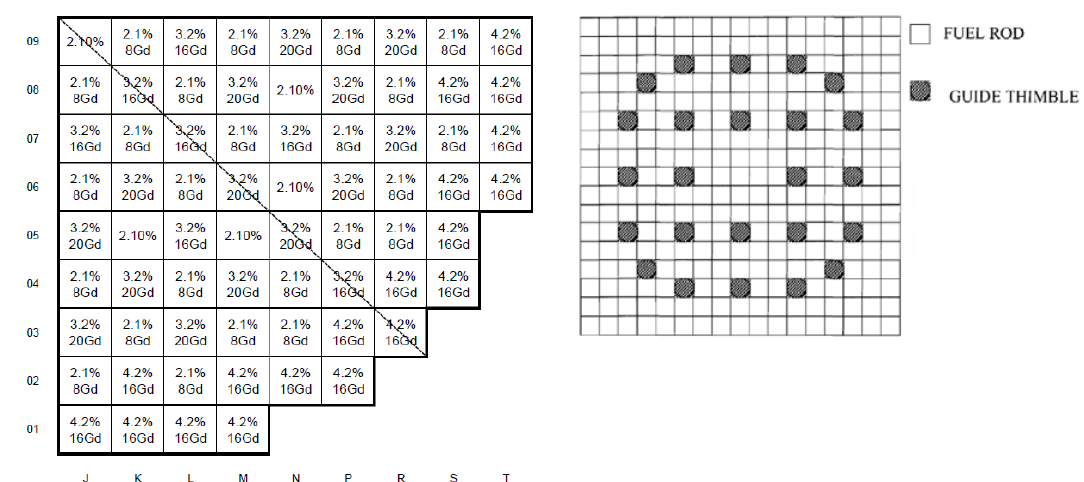
Figure 3. Core loading pattern for EPR first cycle and one assembly layout